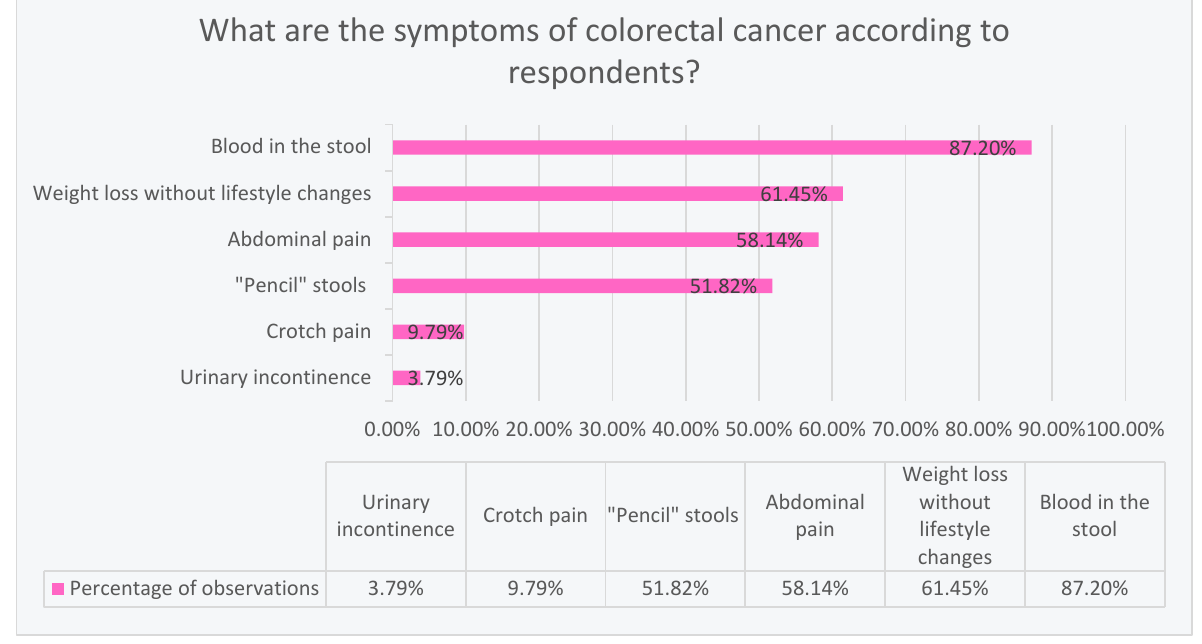
Figure 4. Symptoms of colorectal cancer according to respondents’ knowledge.